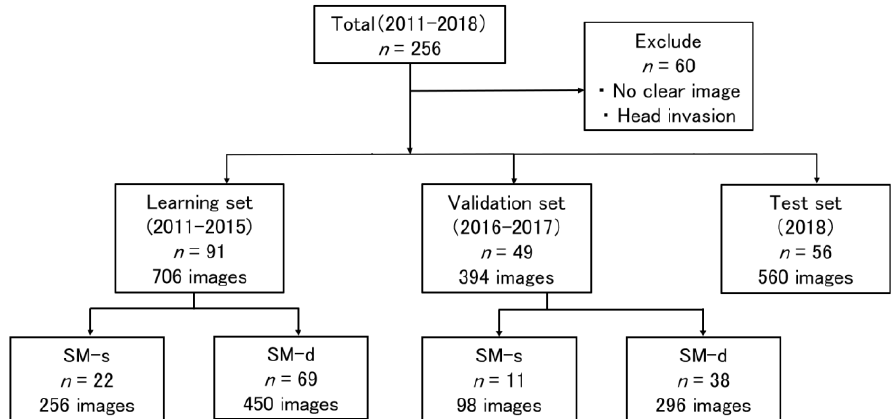
Figure 1. Study population diagram. Patients were classified into the learning set group, for which data was collected from 2011 to 2015, and the validation set group, for which data was collected from 2016 to 2017. SM-s: shallow SM invasion (<1000 µ m), SM-d: deep SM invasion ( ≥ 1000 µ